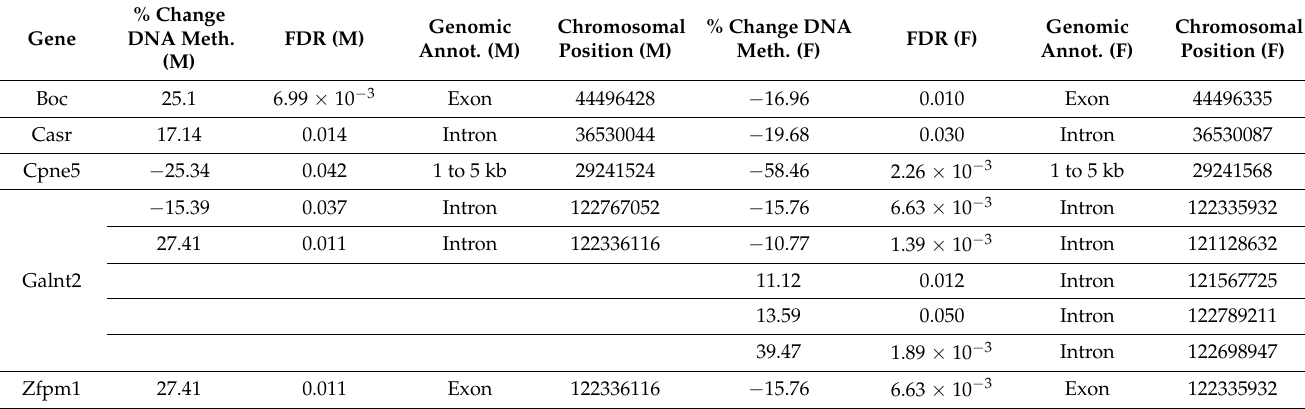
Table 3. DMC-associated genes exhibiting differential DNA methylation in both males and females.